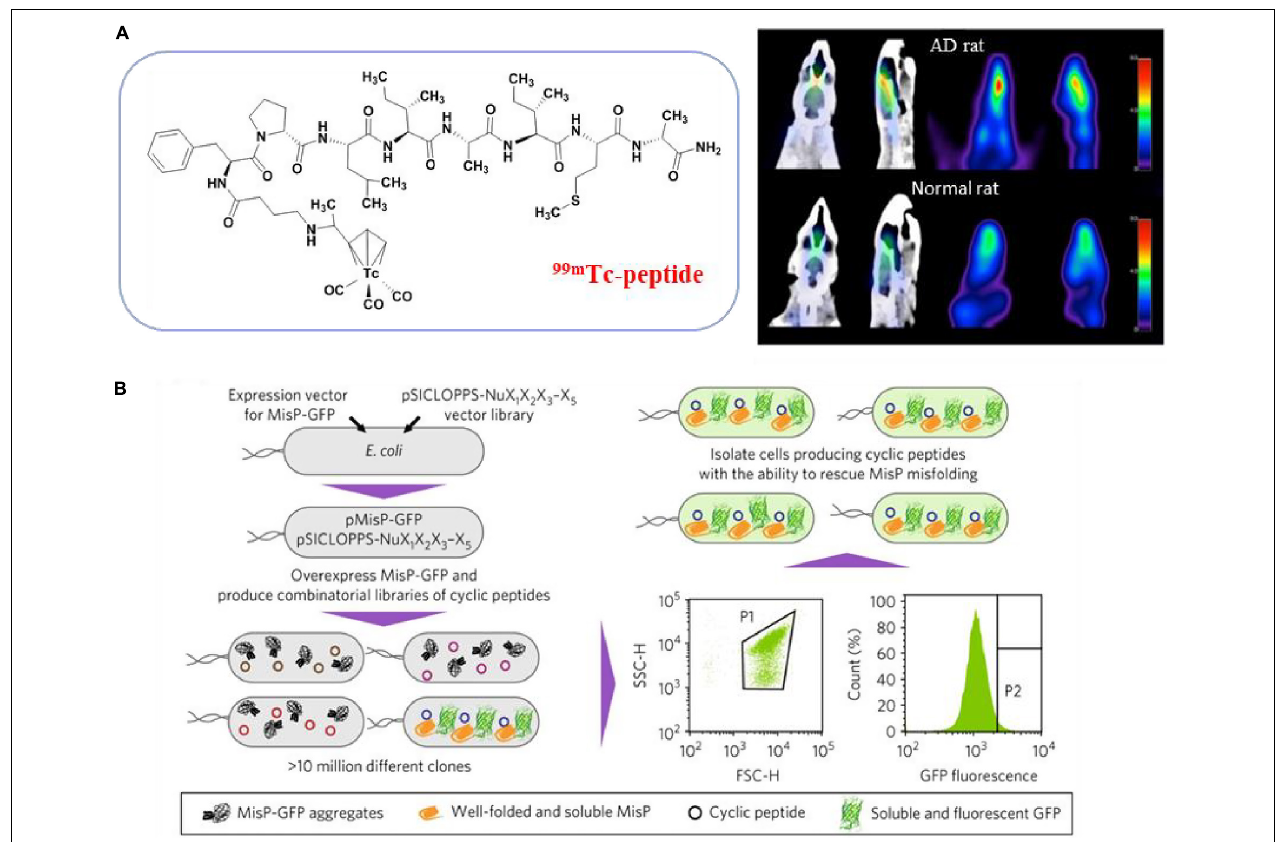
FIGURE 3 | Peptides from phage display library screening methods. (A) Transform the peptide obtained from phage display screening to get SPECT imaging agent (Jokar et al., 2020); (B) schematic overview of the strategy for bacterial library screening used FACS (Matis et al., 2017). Reproduced with permission. Copyright 2017, Springer Nature. TABLE 3 | A β -targeting peptides identified from bacterial-display peptide libraries. Receptor Sequence Library